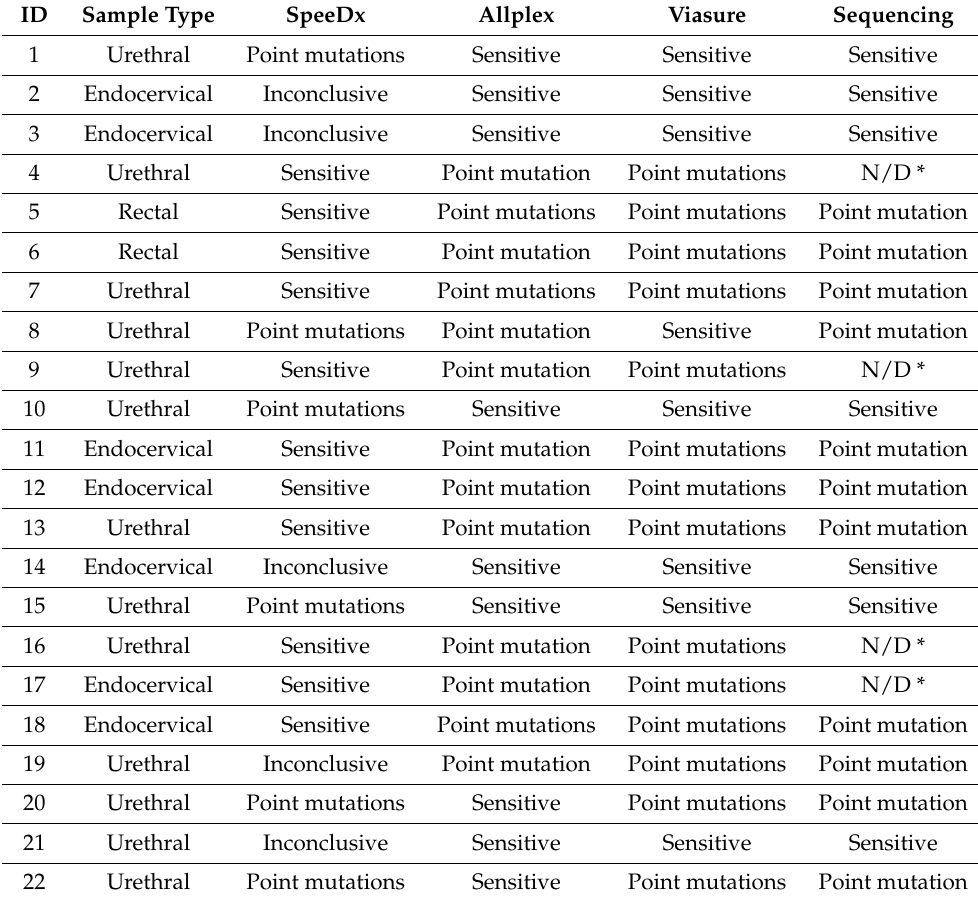
Table 2. Discrepancies among ResistancePlus ® MG panel kit (SpeeDx), VIASURE macrolide resistance-associated mutations (23SrRNA) Real time PCR detection kit (Viasure), and AllplexTM MG & AziR Assay (Allplex) and sequencing